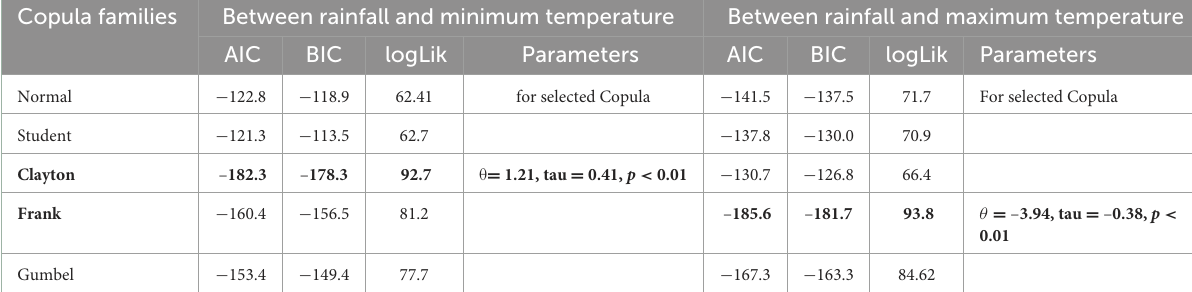
TABLE 7 Results of different copula models for mean annual rainfall with minimum and maximum temperature. Copula